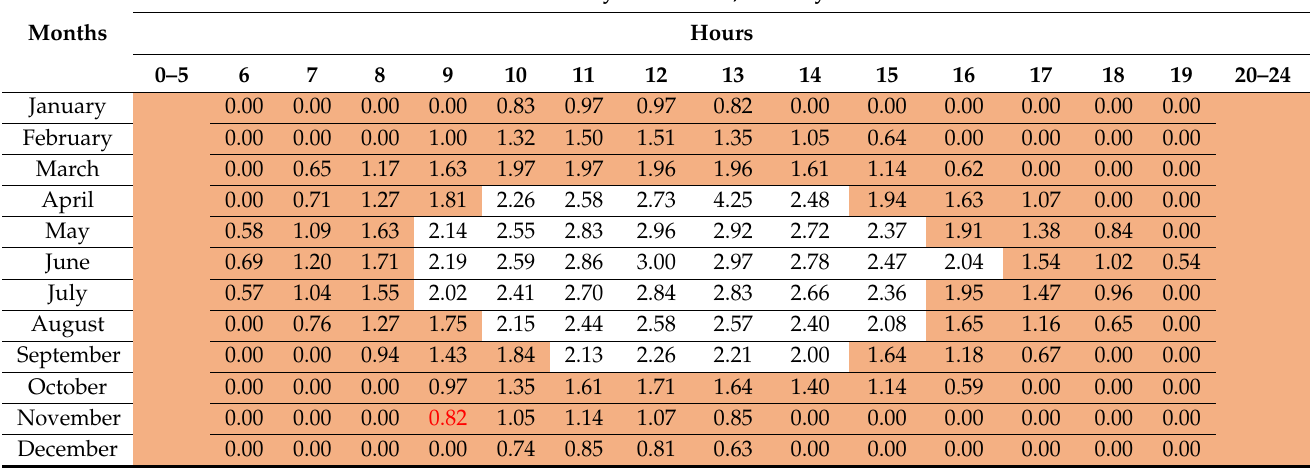
Table 16. Hours during which the power generated by the designed photovoltaic system will be sufficient for the effective operation of the unit “Water heater” (without taking into account the degradation of the system). The hours when there is not enough electricity produced by the photovoltaic system are marked in